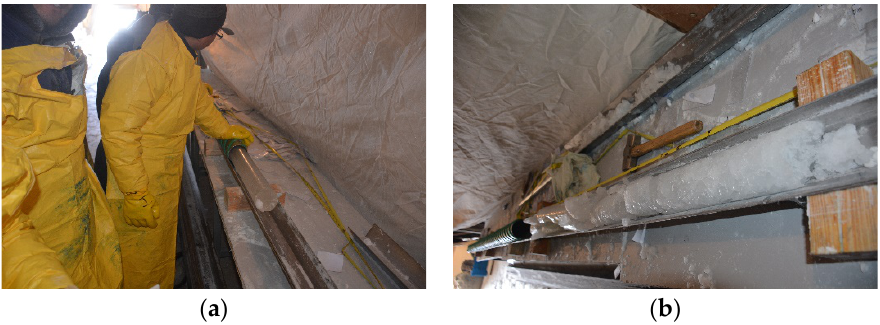
Figure 11. Different ice-core states. ( a ) For an unbroken ice-core; ( b ) for a fissured ice-core.